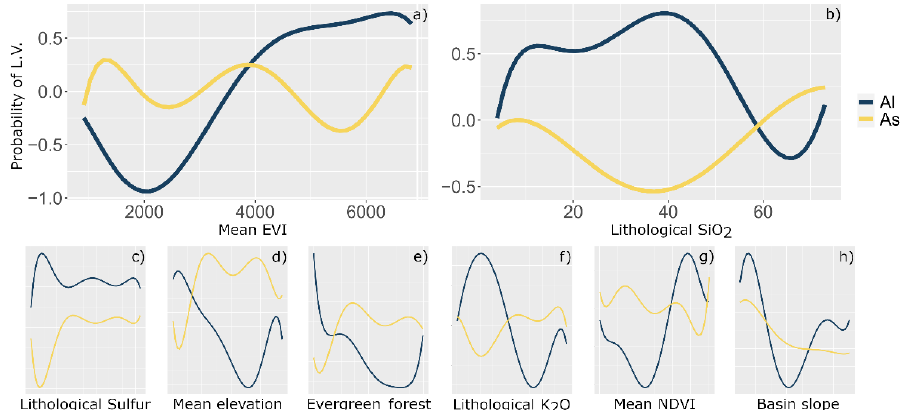
Figure 4. PDP plots for group C1. The x -axis represents a MIV, the y -axis represents the associated probability of a L.V. (lower value) classification. Each line represents the relationship for a single metal. The plots show: ( a ) Mean EVI (the mean EVI of the drainage area above the sample location), ( b ) Lithological SiO 2 (mean accumulated percentage of lithological silicon dioxide content), ( c ) Lith- ological sulfur (mean accumulated percentage of lithological sulfur (S) content), ( d ) Mean elevation, ( e ) Evergreen forest, ( f ) Lithological K 2 O (mean accumulated percentage of lithological potassium oxide content), ( g ) Mean NDVI and ( h ) Basin slope. “ EVI ” = Enhanced Vegetation Index, “ NDVI ” = Normalized Difference Vegetation Index. Lines are displayed after smoothing with a polynomial regression for display purposes.